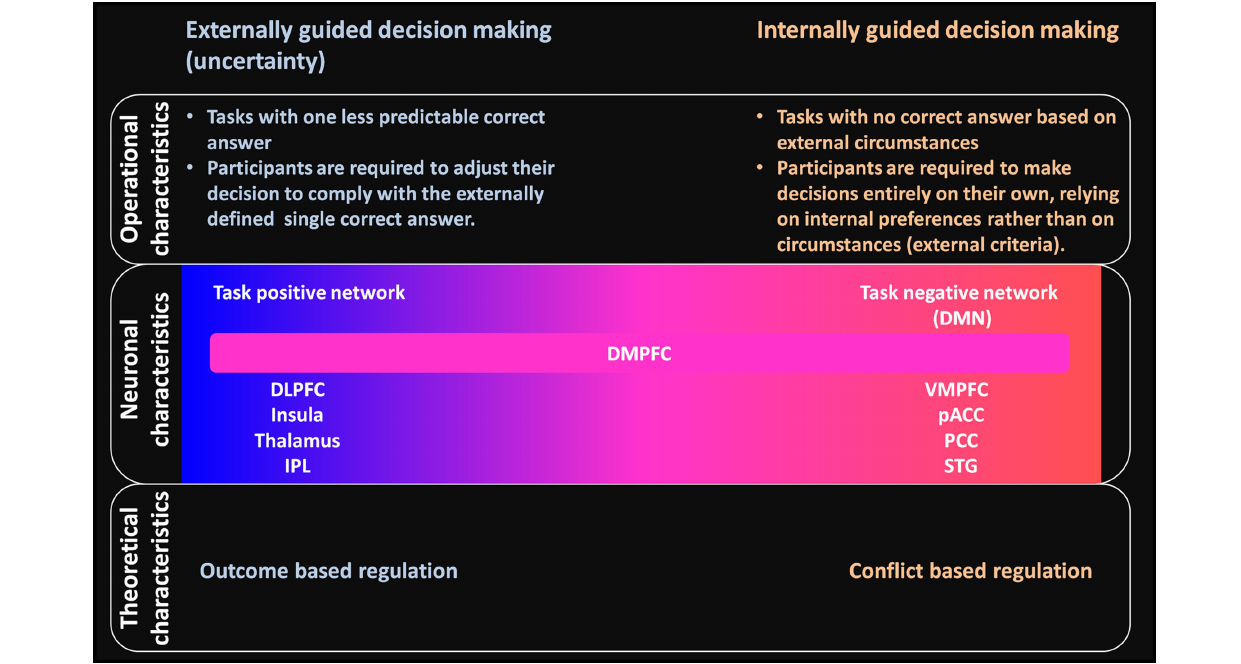
FIGURE 4 | Schematic summary of differences and relations between externally and internally guided decision-making in terms of operational, neuronal, and theoretical characteristics. Operational characteristics: clear differences are apparent between these two types of decision-making related to the availability of an externally determined correct answer. Neuronal characteristics: externally guided decision-making under uncertainty is mainly supported by the task-positive network (DLPFC–insula–thalamus–IPL network). In contrast, internally guided decision-making is supported mainly by the task negative, default mode network (DMN).The DMPFC is commonly activated in decision making of these kinds and has functional relations with